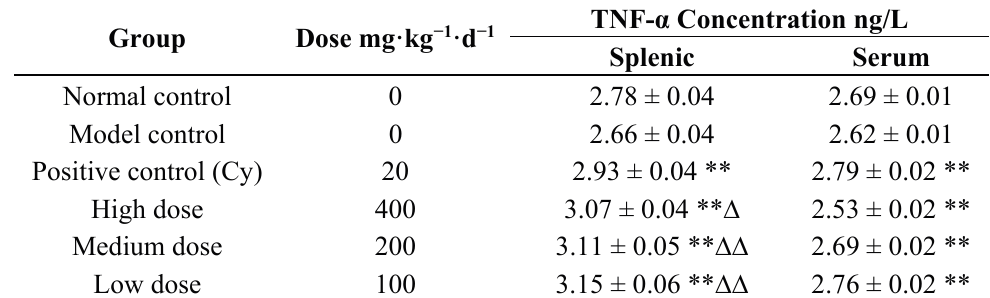
Table 4. Effects of BBP3-1 on immune factors TNF- α in lymphocytes ( x ± s, n = 10).